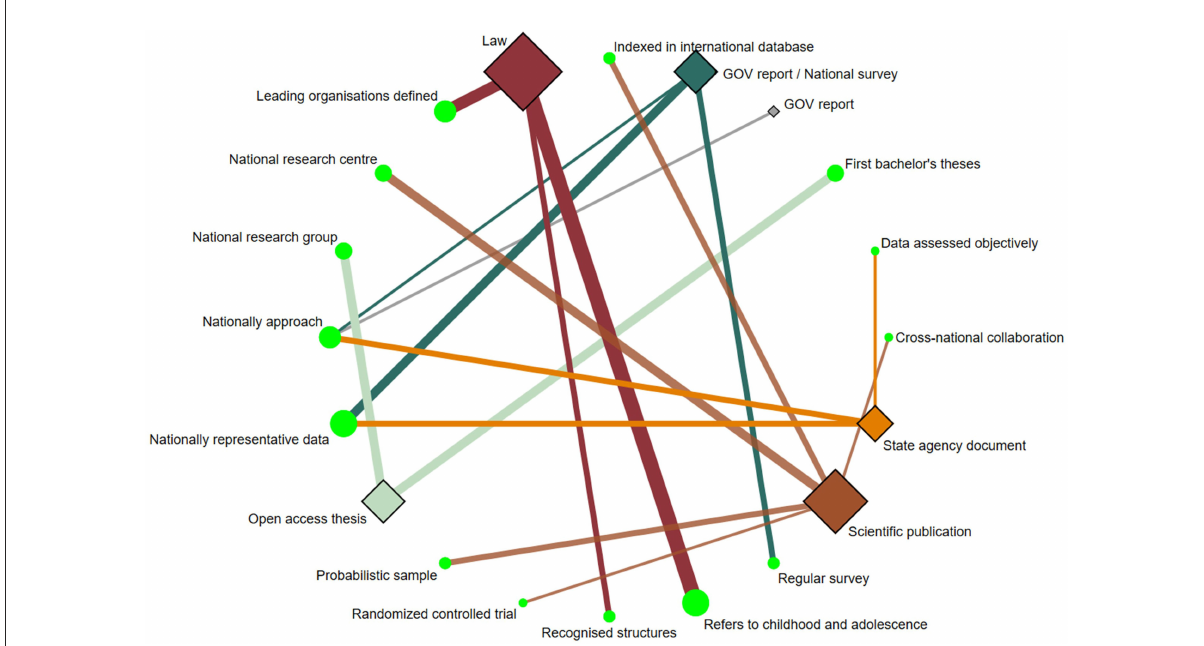
FIGURE5 Network geometry plots of available comparisons between the type of evidence and their strengths. The size of the circular nodes (evidence strengths) was relative to the number of papers analyzing these components. The size of the diamond nodes (type of evidence) was relative to the number of available data on evidence strengths analyzing these components. The width of the solid line connecting the nodes was relative to the number of papers analyzing the evidence strengths (circular nodes) according to the type of evidence (diamond nodes). GOV, Government.